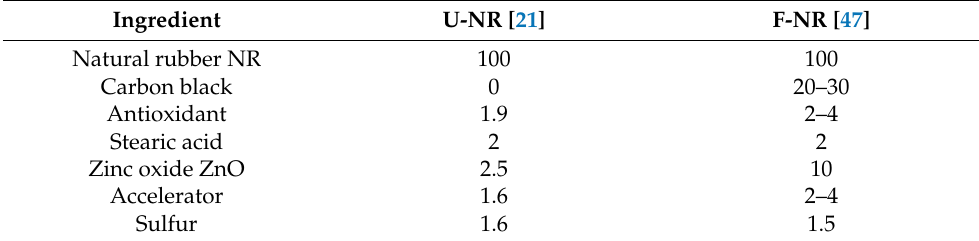
Table 1. Chemical composition in parts per hundred rubber